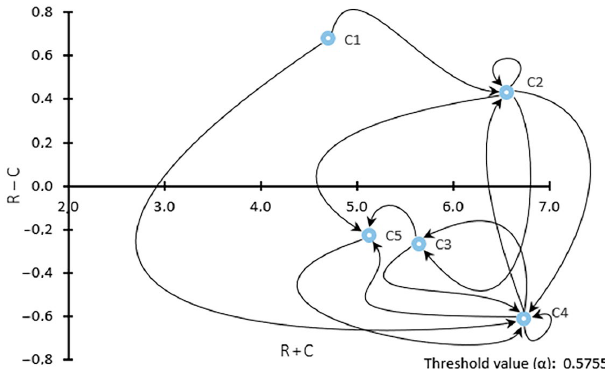
Figure 2. DEMATEL inter-cluster relationships